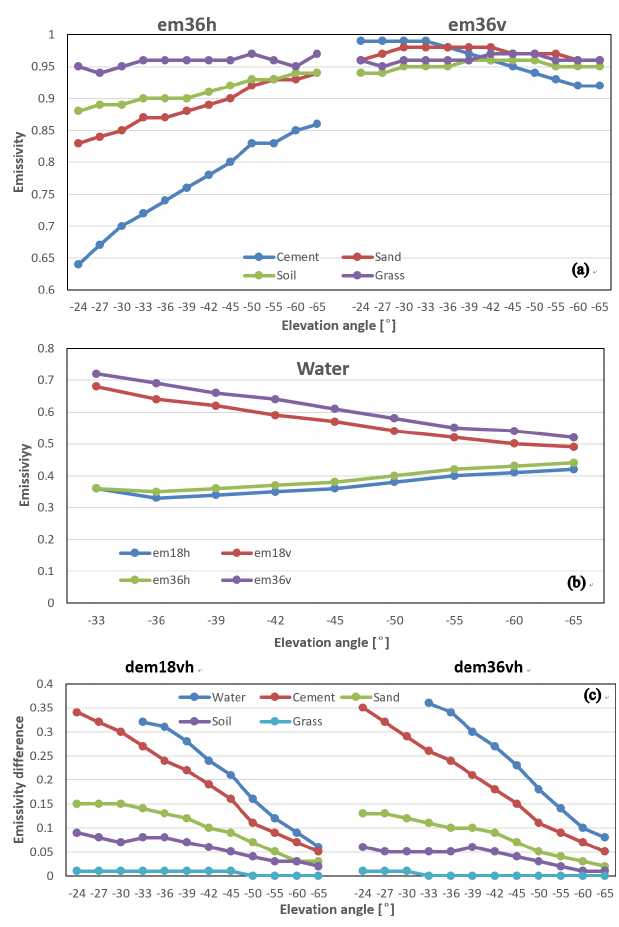
Figure 8. Variations in the surface emissivity (a, b) and ε polariza- tion differences (c) over different surfaces with increasing elevation angle in October